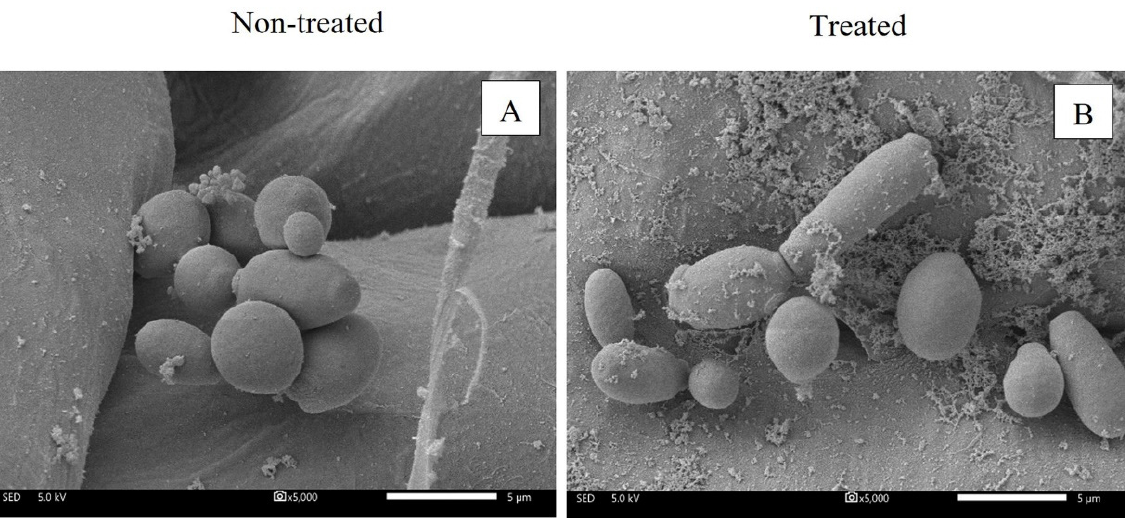
Figure 5. Scanning electron micrographs of C. tropicalis on coconut husk at 5000 × magnification; non-treated ( A ) and treated with 15:20% ( w/v ) salt/acid solution for 10 min ( B ), respectively.